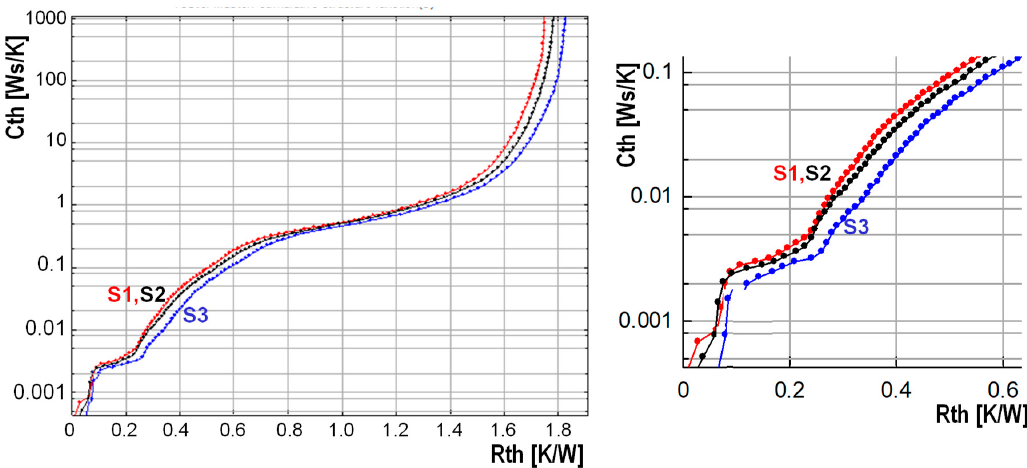
Figure 14. Die-attach comparison of three MOSFET samples (S1, S2, S3).